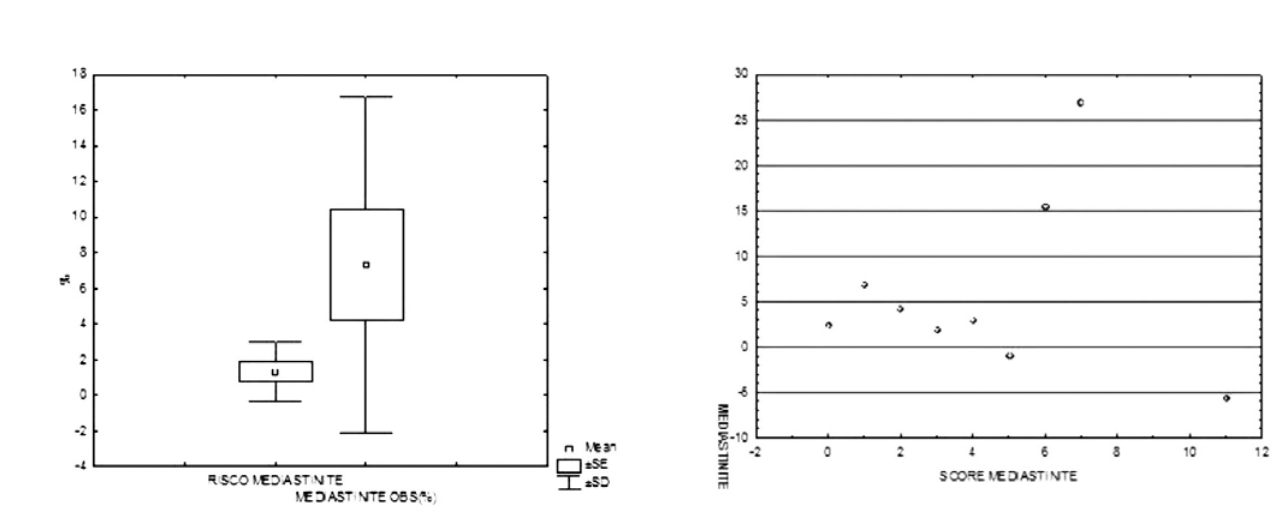
Fig. 2 - Dispersão da diferença entre a incidência de mediastinite observada e estimada segundo escore da